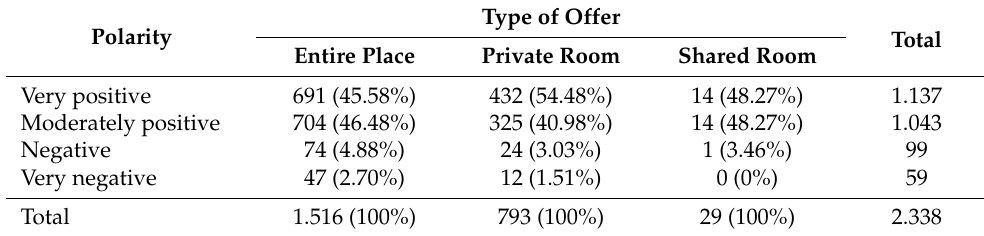
Table 4. Results of sentiment analysis by type of